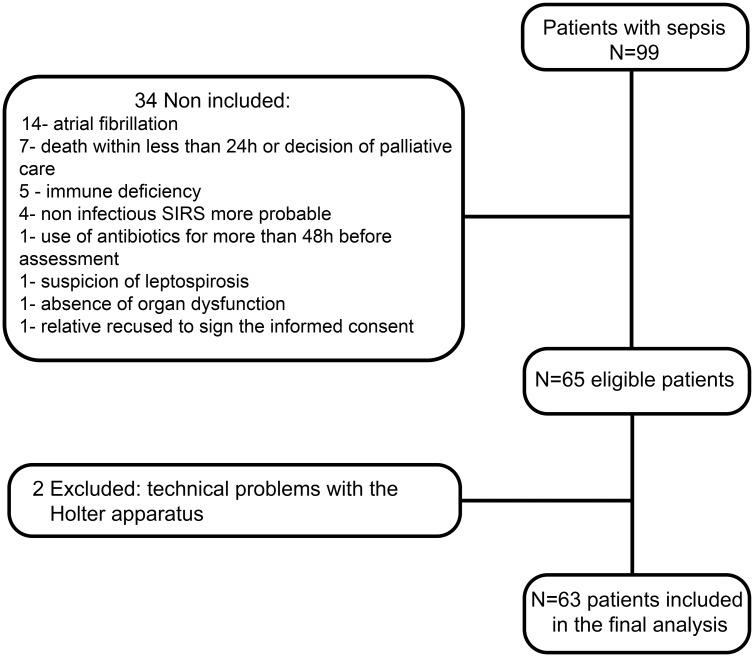
Flowchart of study procedures.